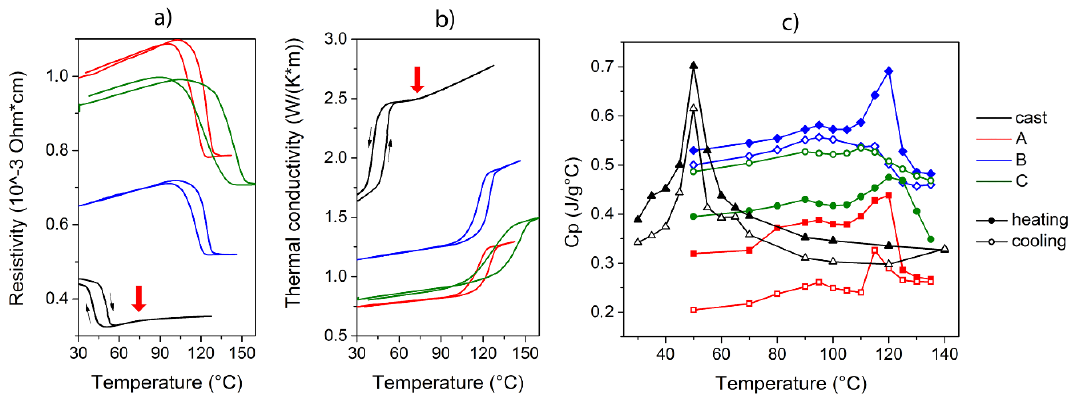
Figure 7. Resistivity vs. Temperature measurement ( a ), calculated thermal conductivity vs. Temperature ( b ) and specific heat vs. Temperature measurement ( c ) for the investigated samples. The red arrows in ( a , b ) indicate the change in slope observed for cast sample.